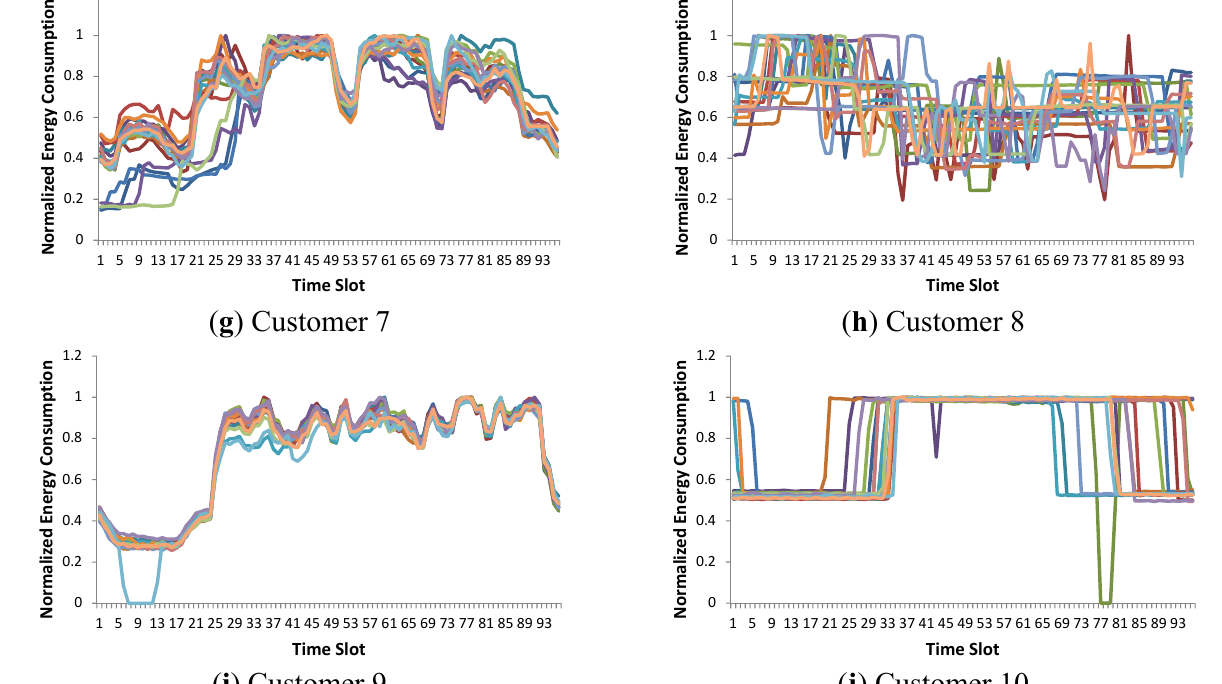
Figure 4. Daily profiles of 10 randomly selected customers. Each line is considered to be a virtual customer. There are a total of 180 virtual customers. ( a )–( j ) Customers 1–10. The index of focus in this paper is the entropy of clustering [26]. An external clustering validity index, entropy, is defined in Equation